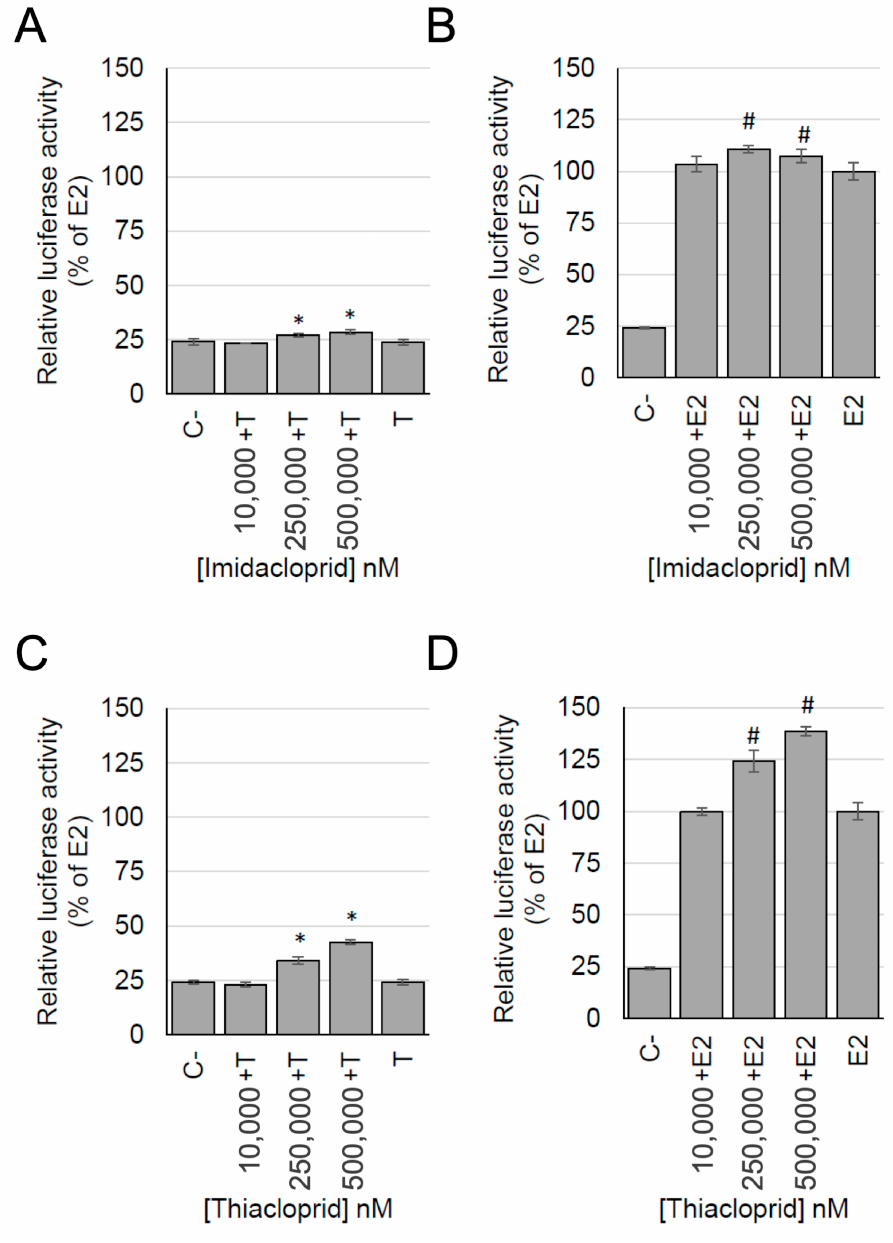
Figure 5. Estrogenic activity, measured with the MELN gene reporter assay, of imidacloprid ( A , B ) and thiacloprid ( C , D ) in combination with E2 (10 − 10 M) ( B , D ) or in combination with tamoxifen (10 − 6 M) ( A , C ). Data are expressed as the relative luciferase activity (% of E2 10 − 10 M). C − : Negative control; E2: E2 10 − 10 M; T: Tamoxifen 10 − 6 M. * p < 0.05 vs. C − ; # p < 0.05 vs. E2; Kruskal-Wallis test followed by the post-hoc Dunnett test.